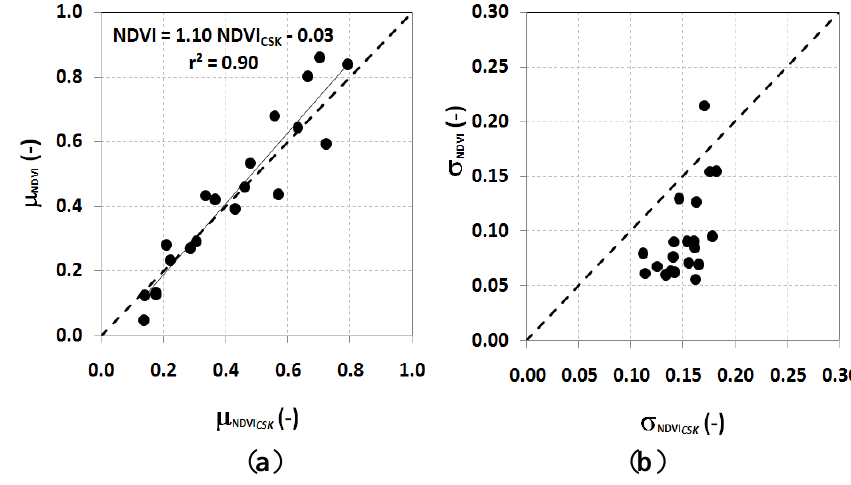
Figure 7. NDVI vs. normalized difference vegetation index (NDVI) scatterplot of CSK ( a ) average values and ( b ) st.dev within homogeneous areas selected using the k-means